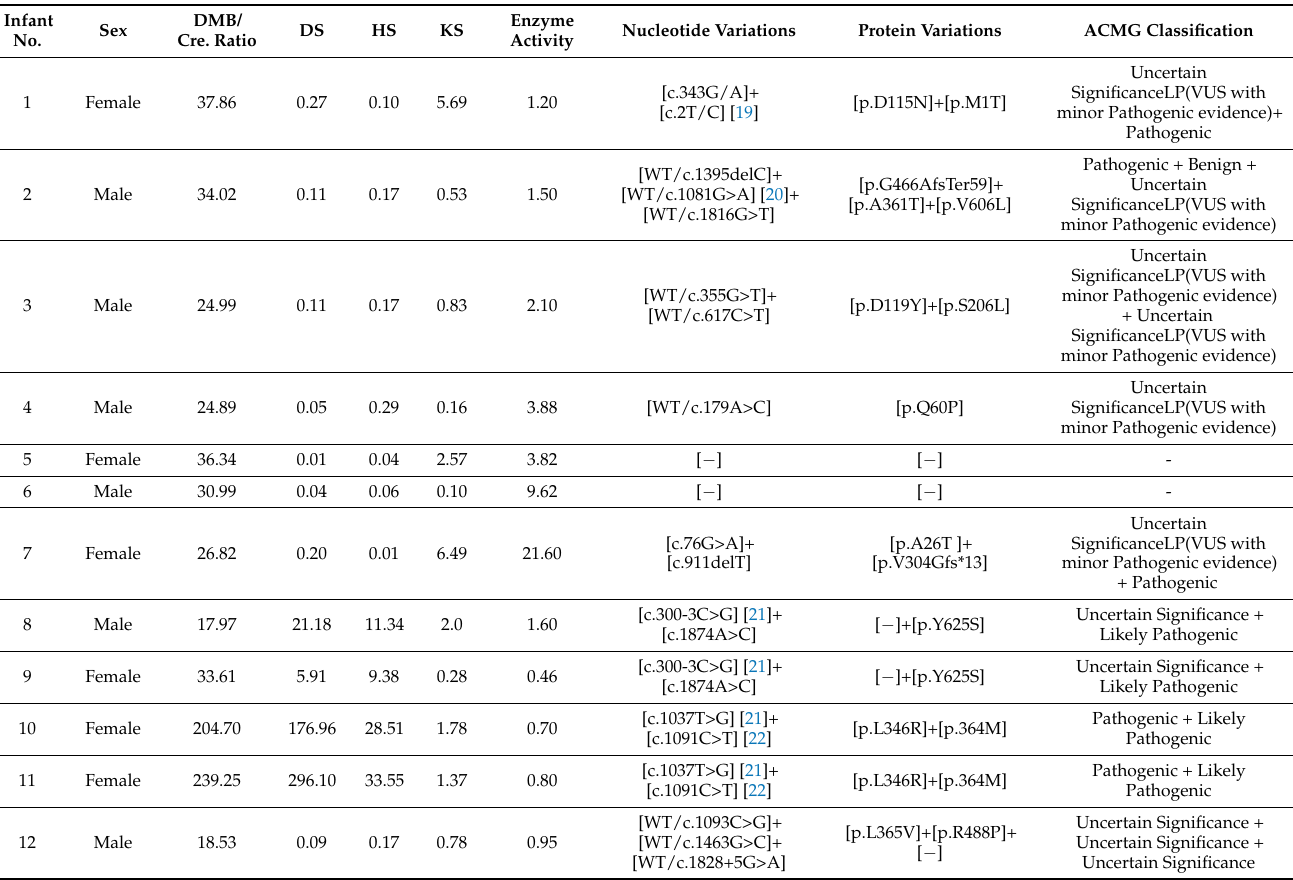
Table 1. Biochemistry GAG tests, enzyme activity, and mutations of alpha-L-iduronidase (IDUA) gene in suspected MPSI infants.